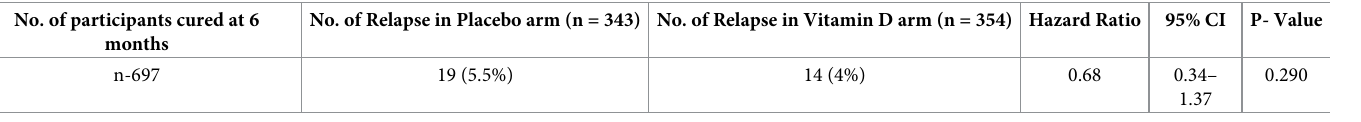
None of the participants in either group developed hypercalcemia. There was no significant difference observed in calcium level during follow up at 6 th month (p = 0.62), 12 th month (p = 0.52), 18 th month (p = 0.17) and 24 th month (p = 0.13). Safety profile (non-serious and serious adverse events) and mortality profile (all-cause deaths) analysis between the two groups (Table 4) showed that 10 (1.1%) patients died during the study [five(1.1%) in the vitamin D group and five (1.1%)in the placebo group]. No death was directly attributable to the study intervention. Excluding death, seven serious adverse events were recorded [4(0.94%) in placebo and 3(0.71) in vitamin D arms). Two (0.4%)patients in vitamin D arm had drug induced liver injury, with 1 patient developing liver abscess, while 4 (0.94%)participants in the placebo arm had serious side effects (one developing ethambutol related ocular toxicity, one developed allergic reaction to the placebo which contained lactose Table 2. Primary outcome of the study. No. of participants cured at 6